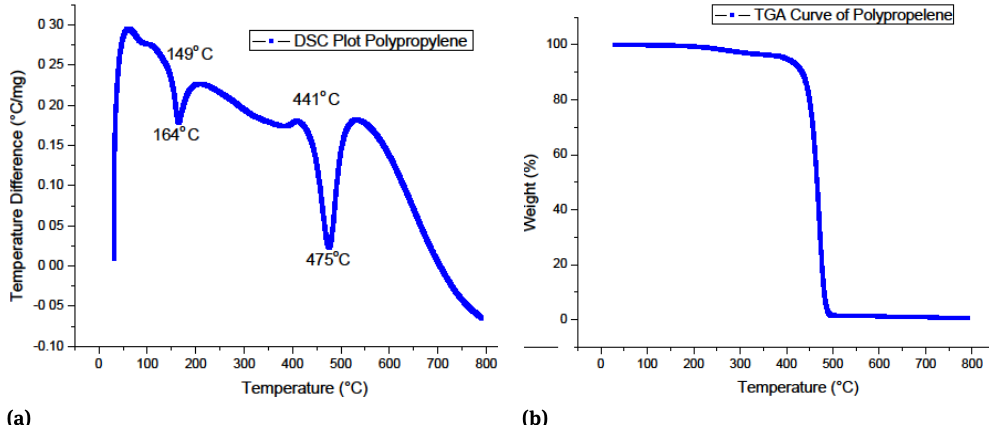
Figure 4: (a) DSC plot of Polypropylene (b) TGA plot of Polypropylene